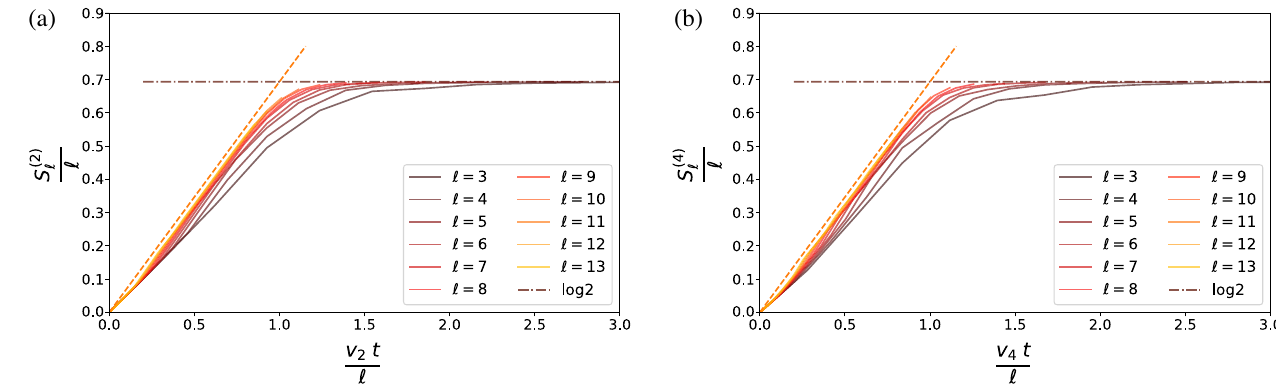
FIG. 6. Tensor network simulations of the entanglement dynamics for Rule 54. We consider an open system of L ¼ 50 sites and we focus on the subsystem A made of the first l sites, with l ¼ 3 ; … ; 13 , represented by solid lines with different colors (see the legend). We fix the bond dimension equal to 4096. The dashed line is the exact prediction for s α t [note the absence of the factor of 2 with respect to Eq. (90) due to the choice of different boundary conditions], while the dot-dashed line represents the asymptotic thermodynamic entropy d α l . Our conjecture (90) corresponds to the joining of the two straight lines. The entanglement velocity that rescales the time is v α ¼ s α =d α